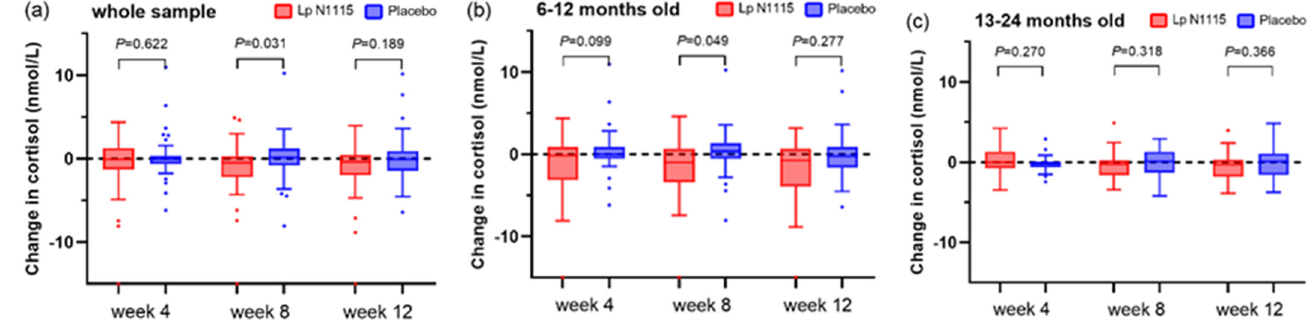
Figure 3. Changes in salivary cortisol from baseline. ( a ) salivary cortisol changes of all partici- pants; ( b ) salivary cortisol changes of 6–12-month-old subgroup; ( c ) salivary cortisol changes of 13–24-month-old